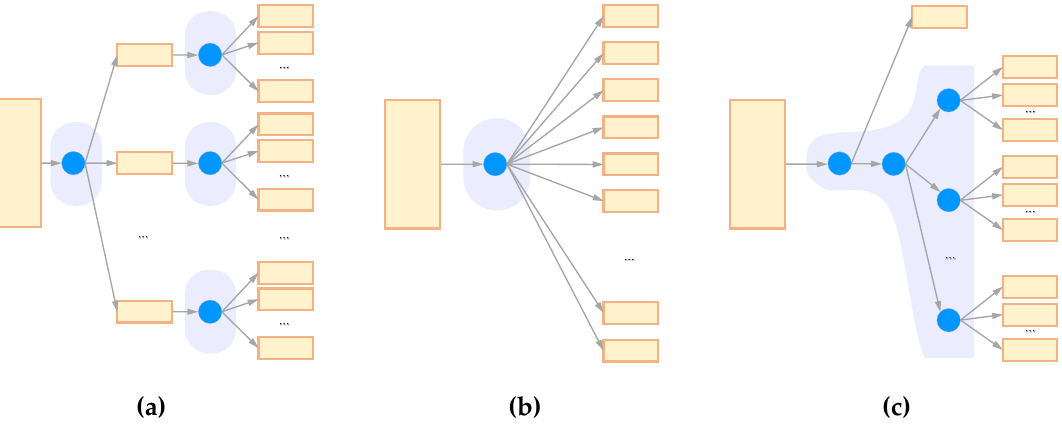
Figure 7. Comparison classification methods: ( a ) two layers multi-class detection model; ( b ) single-layer based multi-class classification model; and ( c ) multi-labeled hierarchical classification model (our